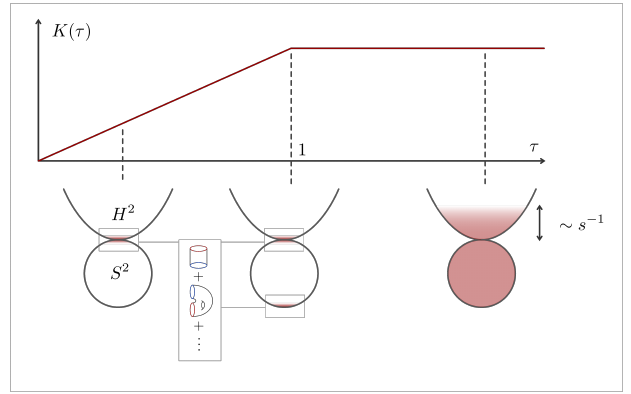
Figure 1: The generic late-time behavior described by the effective theory of quantum chaos. The top line shows the ramp and plateau behavior of a simple observable – the spectral form factor K ( τ ) – and the bottom line shows how the different qualitative regimes are obtained in the sigma model. The ramp behavior is initially well de- scribed by small perturbative corrections around the standard saddle (the north pole × S 2 ). In this phase causal symmetry is of the sphere in the sigma model geometry H 2 spontaneously broken. Around the Heisenberg time τ = 1, one must also include the non-perturbative contributions of the second saddle, as described in (2.25). At very × S 2 and the causal late times the system explores the full Goldstone manifold H 2 symmetry is